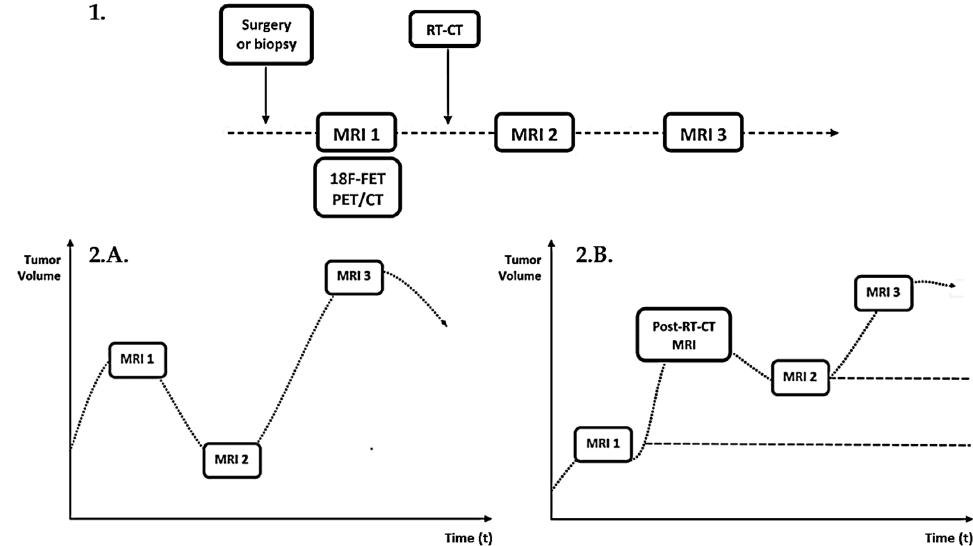
Figure 1. 1: Study design. 2: Diagram of the MRI timeline. A. An example with a smaller tumor Figure 1. 1 : Study design. 2 : Diagram of the MRI timeline. A . An example with a smaller tumor volume on MRI 2 than on MRI 1. B: An example with a higher tumor volume on MRI 2 than on MRI volume on MRI 2 than on MRI 1. B : An example with a higher tumor volume on MRI 2 than on MRI 1 1 (MRI 2 represent the smallest tumor volume in the post-RT-CT follow-up). (MRI 2 represent the smallest tumor volume in the post-RT-CT